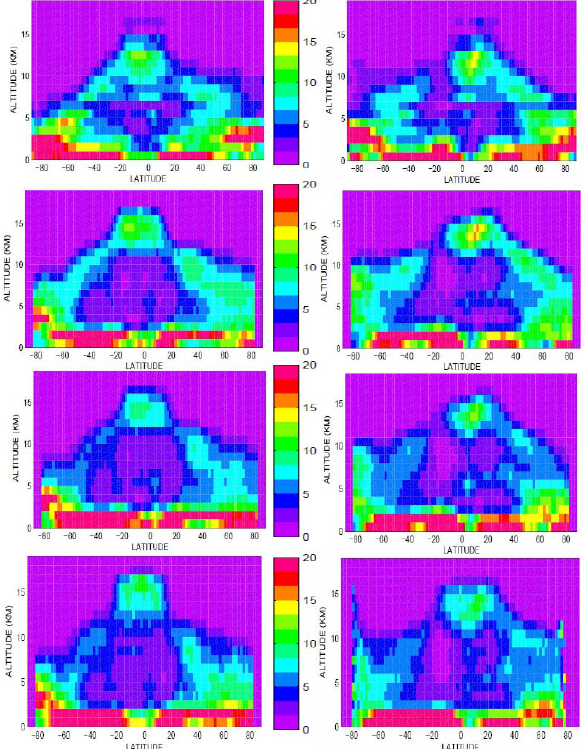
Figure 8: Zonally averaged vertical distributions of relative cloud amount as obtained from AIRS-LMD (top panel), from CALIPSO (once for the uppermost cloud layer and once for all vertical cloud layers, in both cases subvisible cirrus excluded) and from Radar – Lidar GEOPROF (bottom panel), separately for boreal winter (left) and boreal summer (right). The data are normalized in such a way that the sum over all heights for each latitude interval corresponds to 100%. Averages over the period from 2007 to 2008.